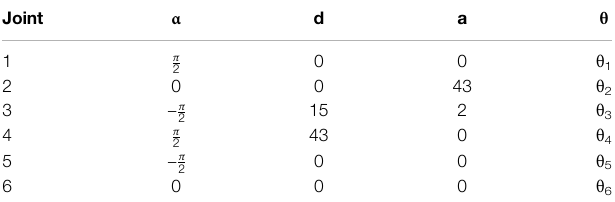
TABLE 1 | DH model parameters of the manipulator Puma 560.